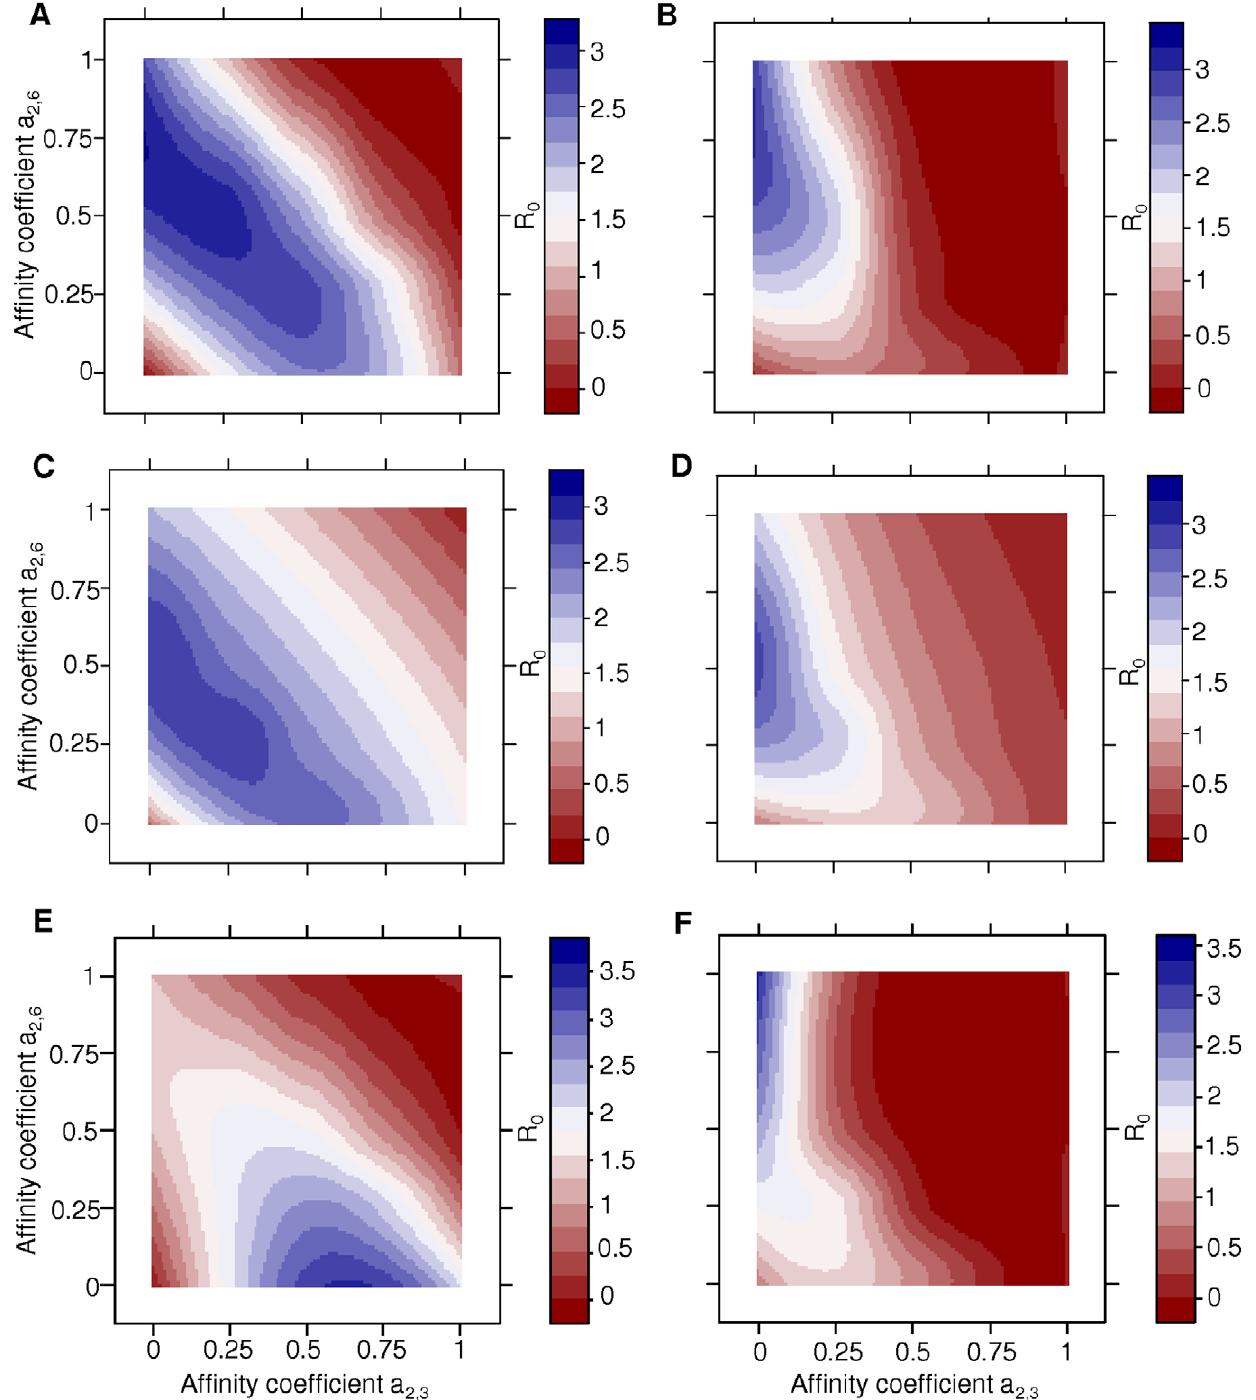
Figure 3. Optimal receptor binding affinity patterns. Contour plots of influenza virus basic reproductive number R 0 (color scales) are drawn when the affinity coefficients a 2,3 (x axis) and a 2,6 (y axis) are varied from 0 to 1. For all graphs, the initial number of susceptible cells differ per respiratory compartment to reflect the heterogeneities in abundance and distribution of epithelial cells with sialic acids with a 2,3 or a 2,6 linkage to galactose. The effect of heterogeneities in viral clearance rates ( x i ) and in the contribution of pathogenicity in each respiratory compartment (P i ) to the overall virus pathogenicity (P) on the virus R 0 is determined, when either non-linear or linear functions link within-host model output of viral excretion (X) and pathogenicity (P) to between-host model parameters. For panels A to D , x 1 . x 2 . x 3 ; for panels E and F , x 1 = x 2 = x 3 . For panels A , C and E , P= g P i ; for panels B , D and F , P=P 1 + 10 2 P 2 + 10 3 P 3 . For panels A , B , E and F , non-linear functions link within-host model output to between-host model parameters; for panels C and D , linear functions link within-host model output to between-host model parameters.